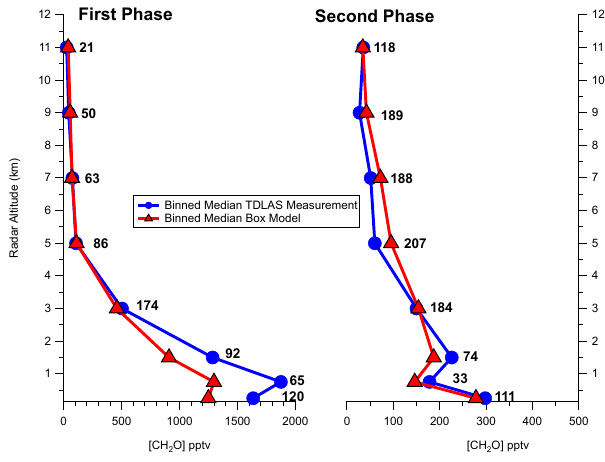
Fig. 4. Radar altitude binned medians for both mission phases. Data are averaged on hydrocarbon time base. The numbers denote the number of time coincident TDLAS measurements and model values in each bin. Table 2. Radar altitude bin statistics for time coincident TDLAS measurements (Meas) and box model (Model) on hydrocarbon time base during the 2nd phase of INTEX-B for the NASA DC-8. All measurement and model results, including (Meas-Model) are in pptv. The difference and ratios were determined from the point- to-point comparisons.